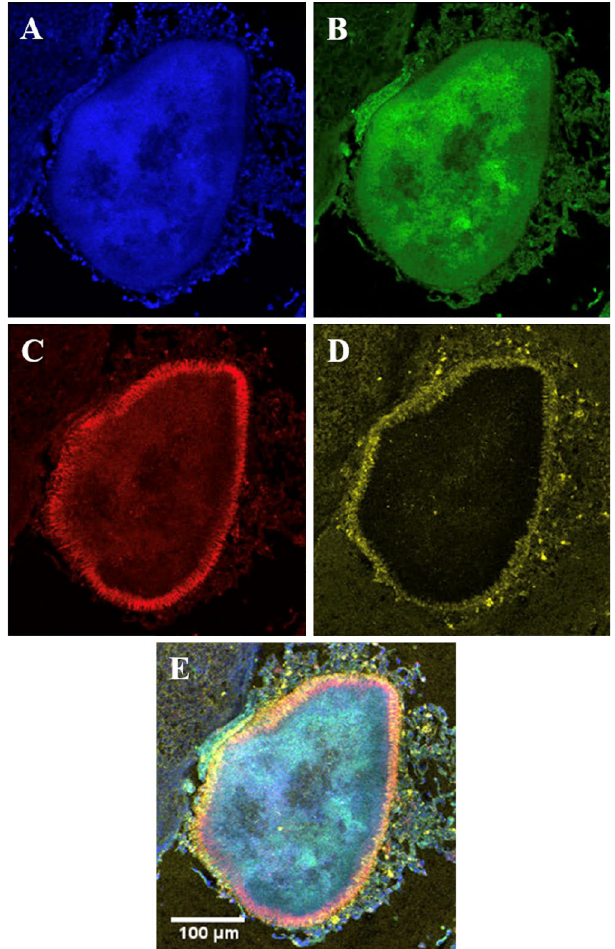
Figure 6. Fluorescence in situ hybridisation staining of Fusobacterium spp . and Bacteroides spp . in a single bacterial microcolony in tonsil tissue. ( A ) Nucleic material/DAPI in blue, ( B ) Eubacterial probe (EUB) in green, ( C ) Fusobacterium spp . specific probe (FUSO) in red, ( D ) Bacteroides spp . specific probe (BAC303) in yellow, ( E ) composite image of ( A – D ). Images at ×10